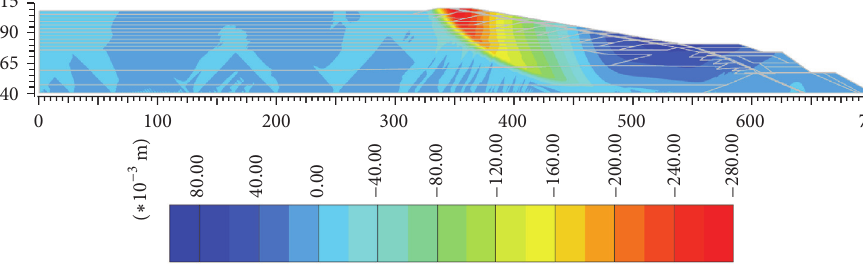
Figure 17: Vertical displacements in the dam after shaking with normal earthquake. The positive direction is